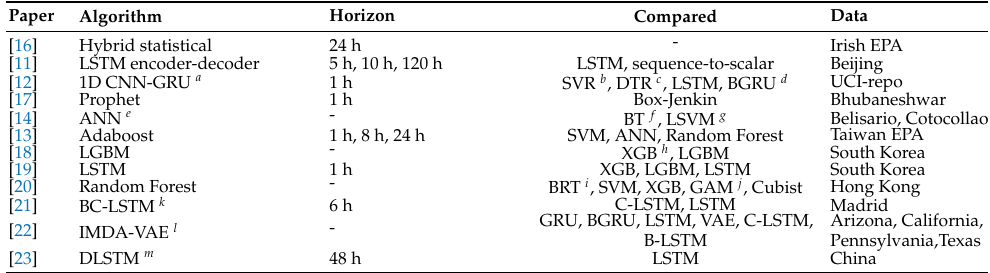
Table 1. State-of-the-art literature